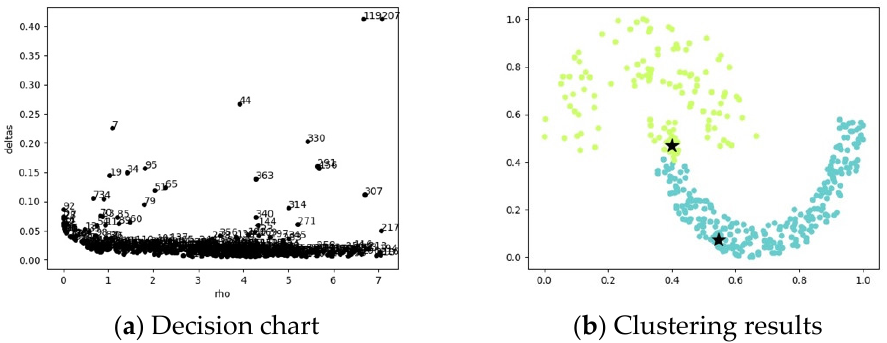
Figure 1. Decision graph and clustering results of DPC on the Jain dataset.